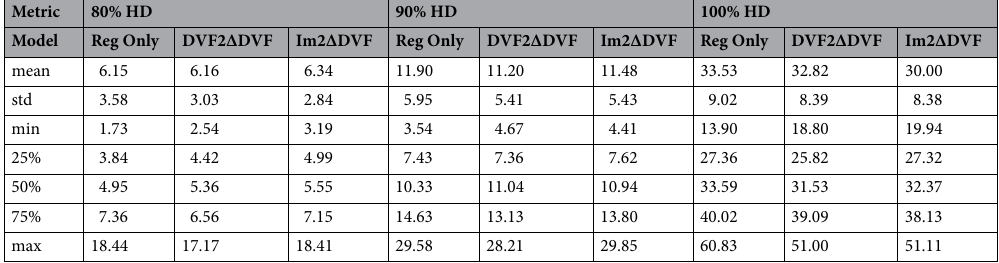
Table 1. Distribution of 80% HD, 90% HD, and 100% HD evaluated between the whole estimated vessel structure and ground truth vessel structure. (unit: